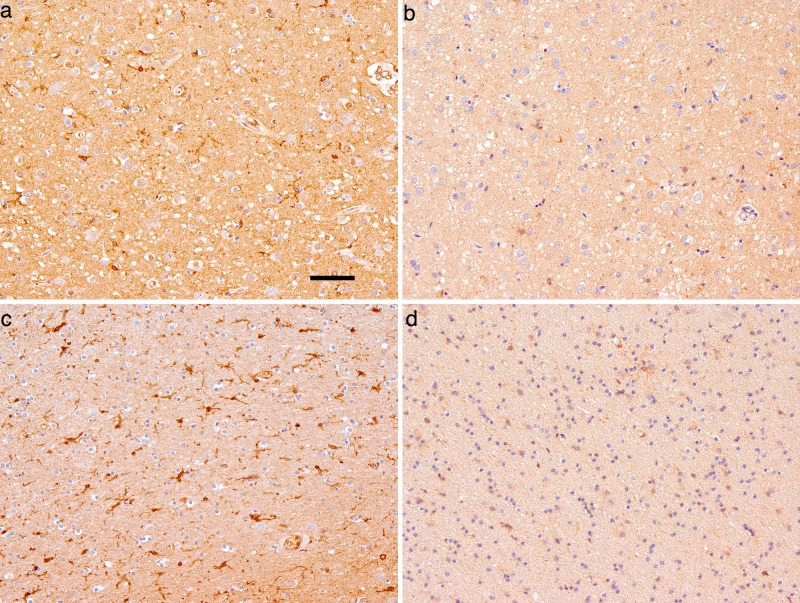
Representative photomicrographs of a sCJD case with AA (a, c) and a sCJD case with GG (b, d) rs6951643 genotype showing differences in mGluR8 immunostaining of microglial cells in the temporal cortex (a, b) and temporal white matter (c, d).Bar represents 50 μm for all images.